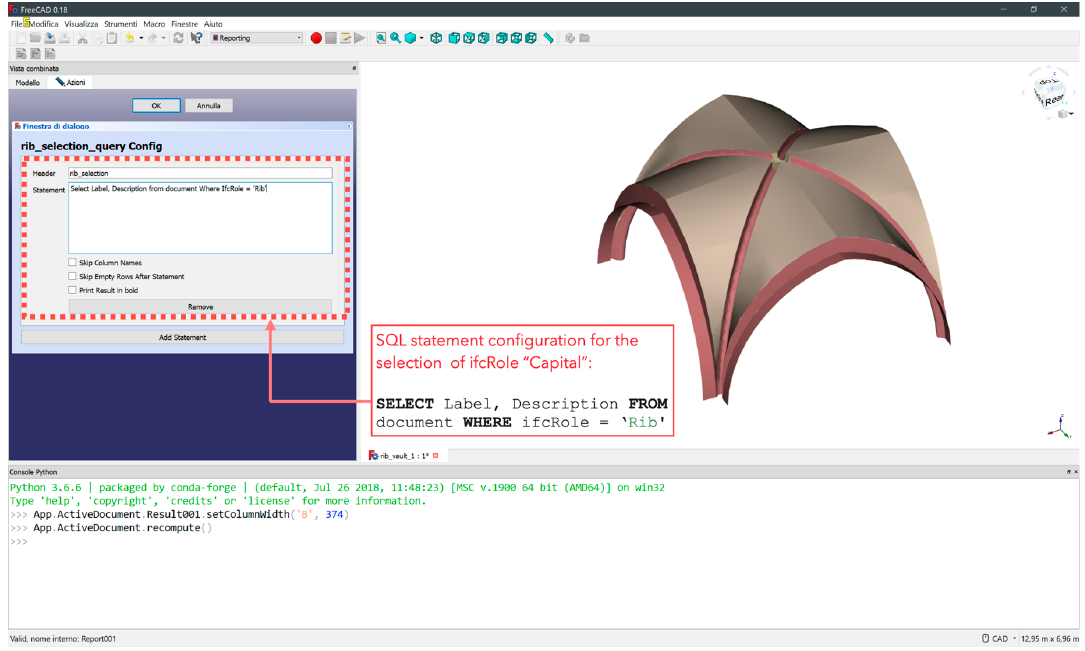
Figure 15. SQL query performed by using predefined statements and datasheet report in order to investigate Rib IFC custom role and its description: on the left side of FreeCAD is the SQL SELECT statement preparation.